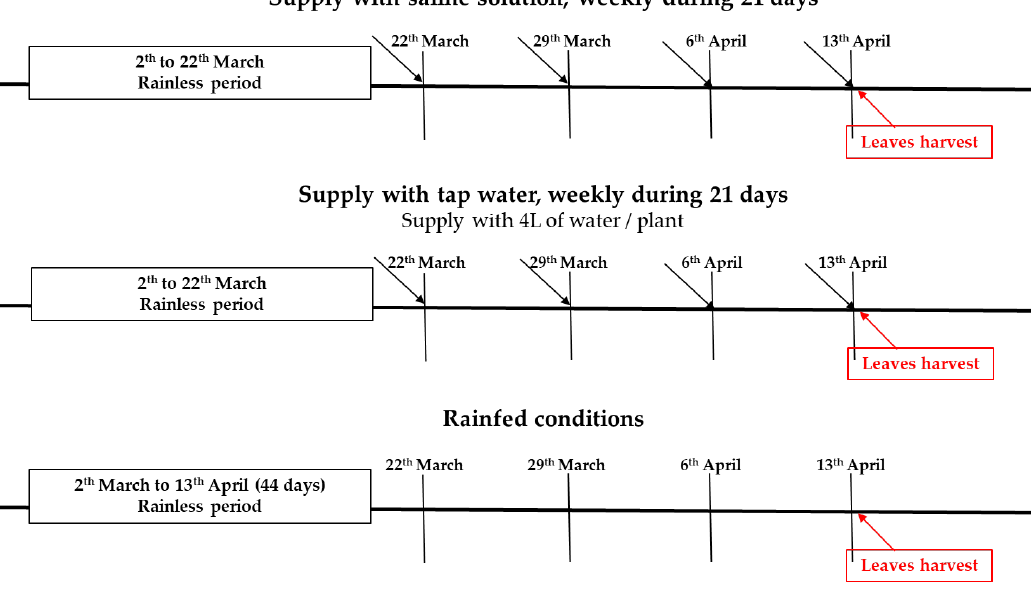
Figure 1. Experimental design and regime irrigation treatments performed on rosemary in 2016 at the experimental station of University of Blida